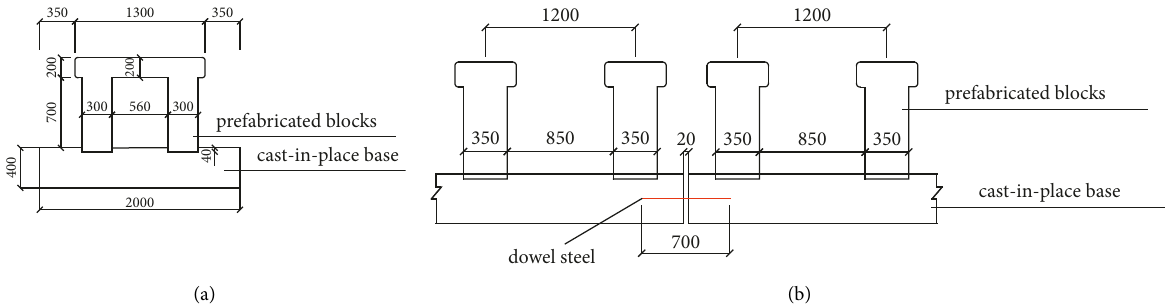
Figure 3: Three-dimensional model diagram.